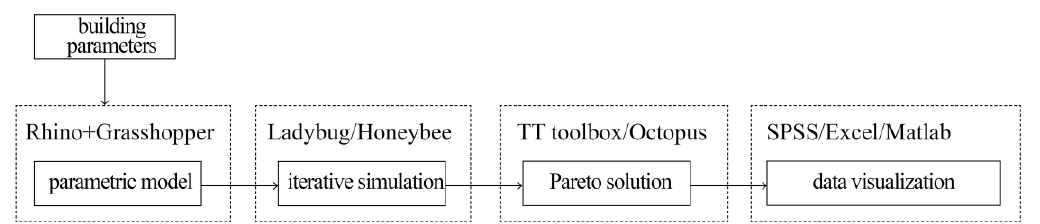
Figure 7. Parametric building optimization process.